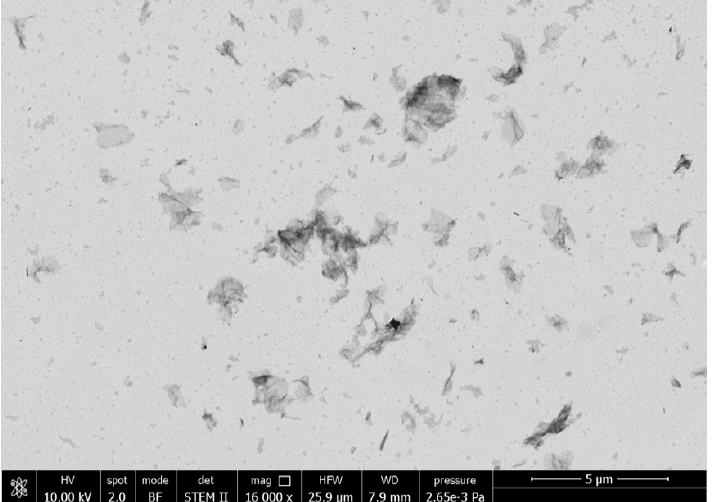
Figure 3. Scanning transmission electron microscopy (STEM) micrographs of rGO dispersed in chloroform.